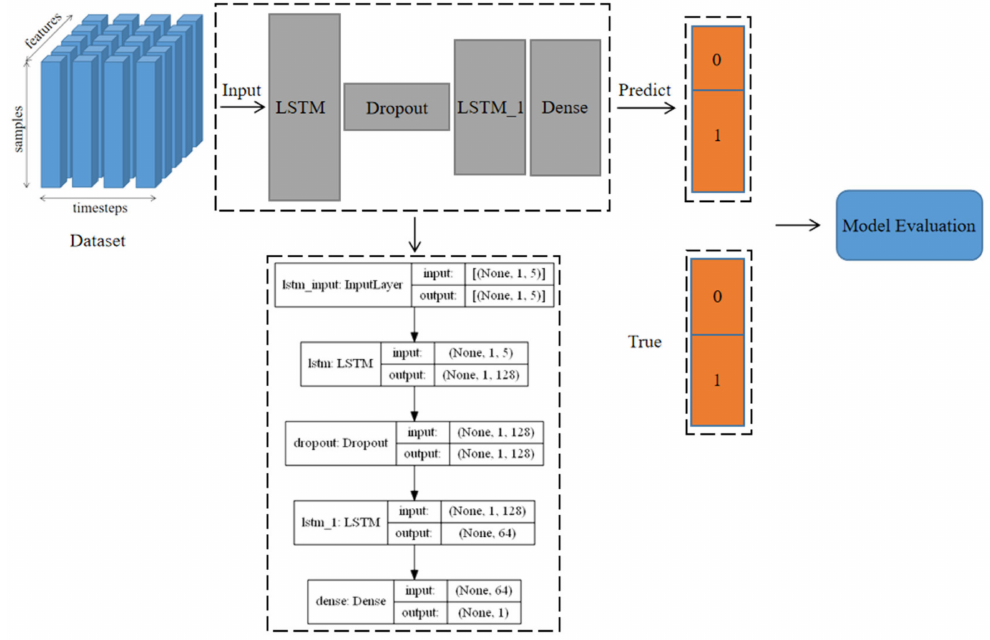
Figure 3. The structure diagram of disease occurrence prediction